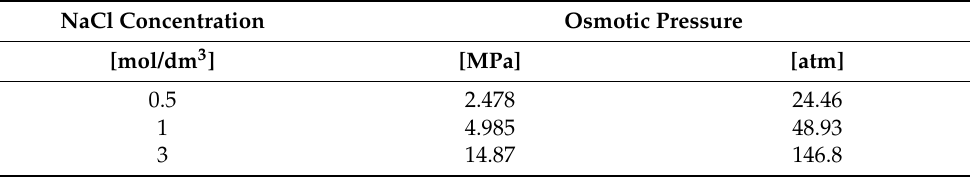
Table 4. Properties of draw solutions.